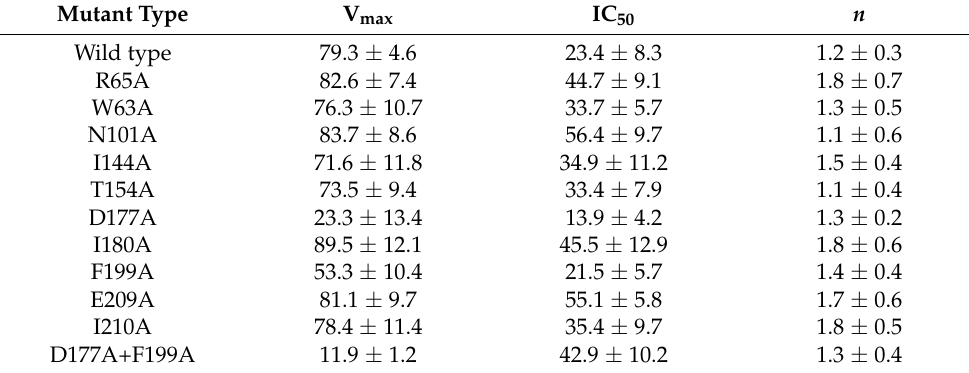
Table 1. Effects of KAE on wild-type and mutant of human 5-HT 3A